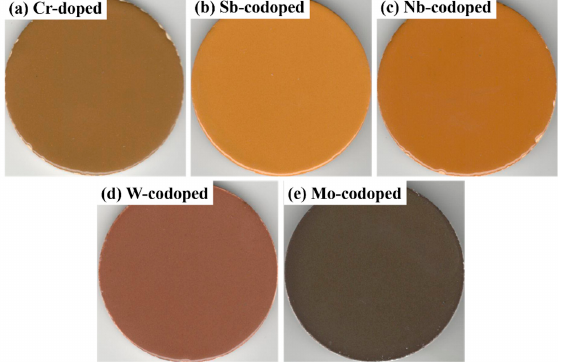
Figure 7. Photographs of the colored ceramic glazes with the Cr-doped TiO 2 pigments without ( a ) and with counterions: ( b ) Sb, ( c ) Nb, ( d ) W, and ( e ) Mo. Table 4. Chromatic parameters of colored glazes with the doped TiO 2 pigments.